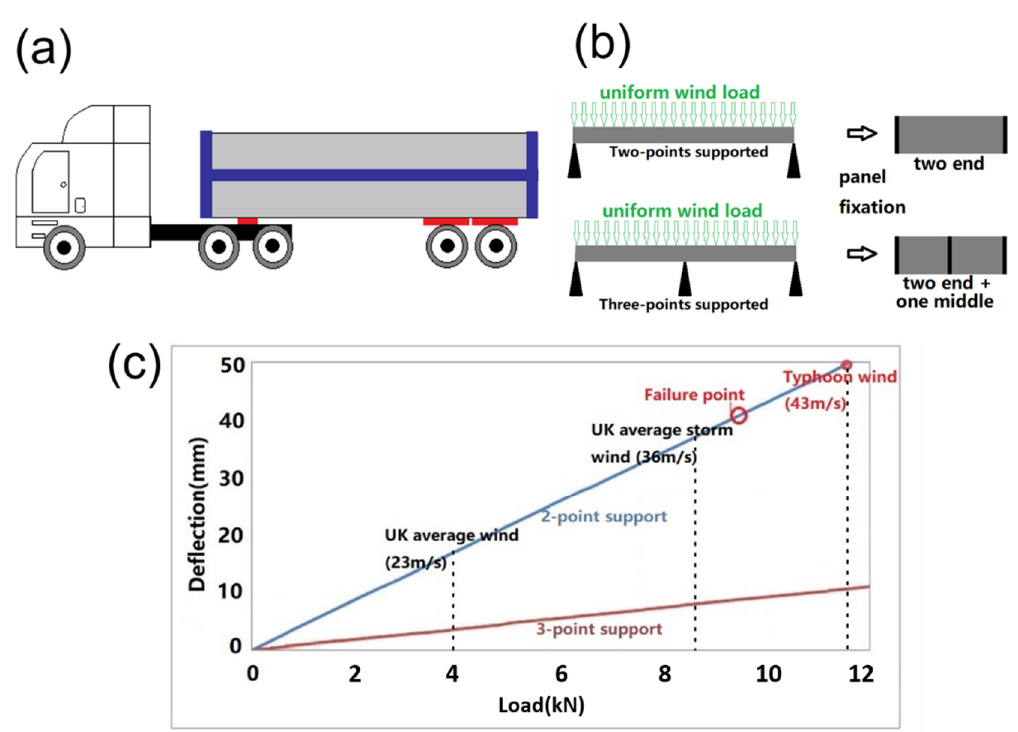
Figure 7. ( a ) Schematic of a truck with grey side panels and blue supportive frames; ( b ) wind load and supporting system illustration. ( c ) Flexural behavior prediction of truck panel with sustainable design.